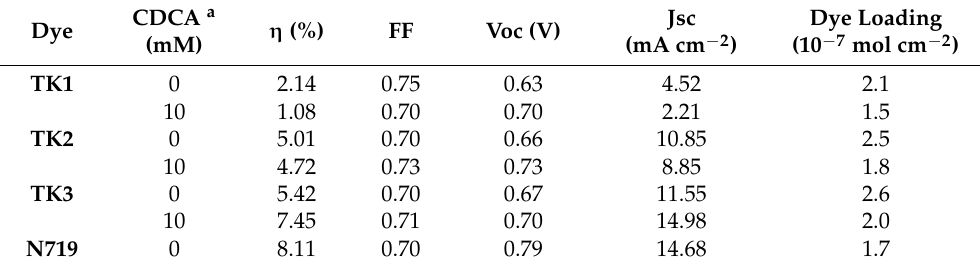
Table 6. Photovoltaic parameters for DSSCs based on dyes TK1 , TK2 and TK3